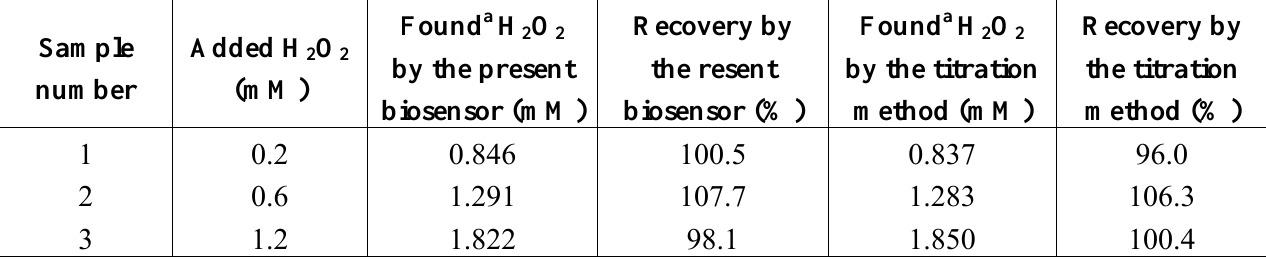
Table 2. Recovery determination